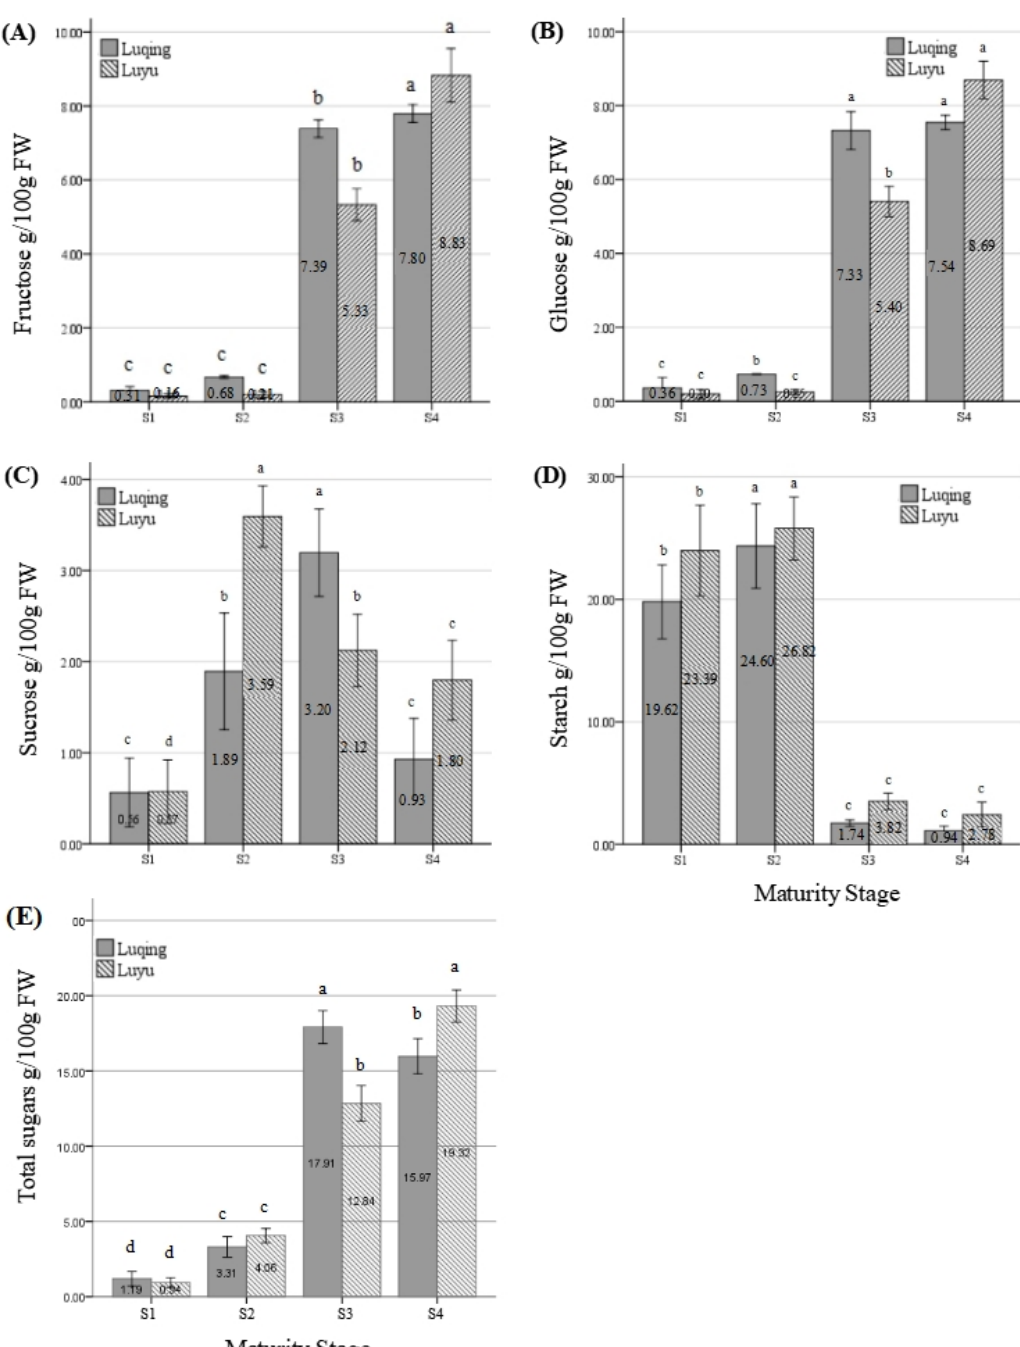
Figure 3. Fructose ( A ), glucose ( B ), sucrose ( C ), starch ( D ), and total sugars ( E ) (the sum of fructose, glucose, and sucrose) concentrations in Akebia trifoliata fruit at four stages of ripening. Error bars indicate standard error from 5 replicates. Means with different letters within each clonal line indicate statistical differences at the p < 0.05 level using the LSD test. S1: 120 days after full bloom (DAFB), S2: 134 DAFB, S3: 148 DAFB, S4: 155